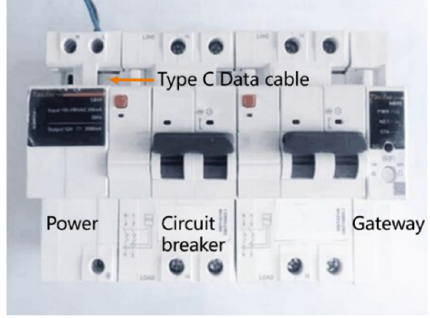
Figure 6. Composition of intelligent MCB.